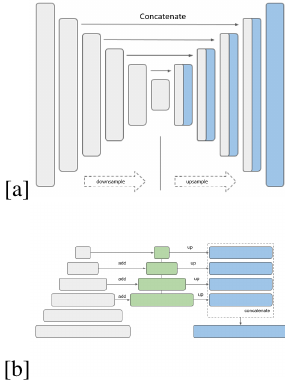
Figure 2. Segmentation models investigated in the study: (a) UNet (b)